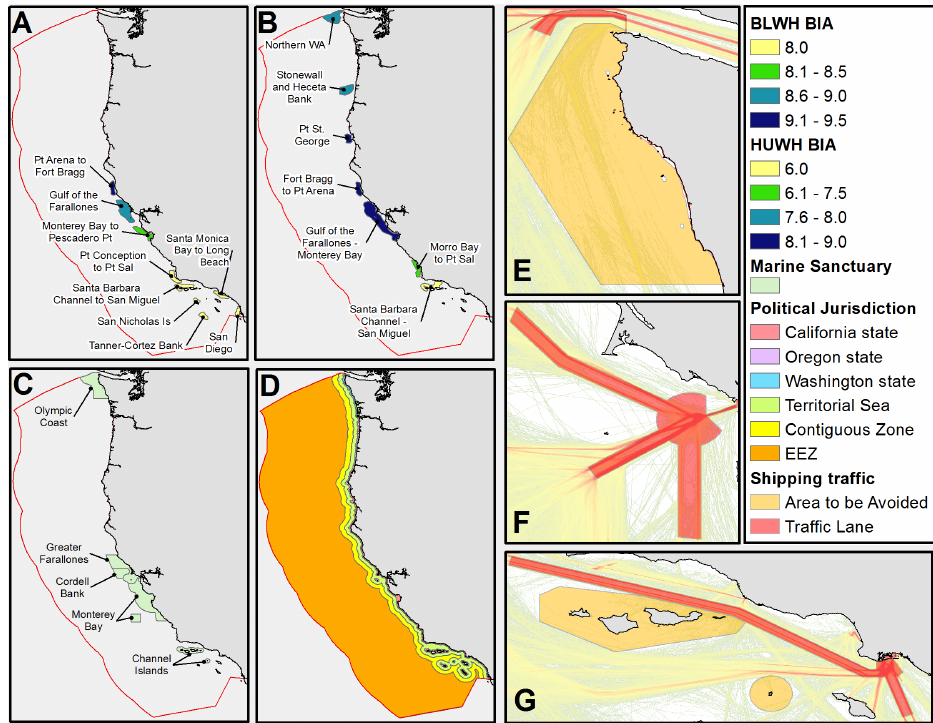
Fig 2. Jurisdictions used to assessthe distribution of mortality. BiologicallyImportant Areas (BIAs) for blue (A) and humpback(B) whalesare from Calambokidis 2015. BIA color represents the mean of the months when whalepresence occurs. Note that the scales are different for the two species. NationalMarine Sanctuaries (C) and politicaljurisdictions(D) includingstate waters (to 3 Nm; 5.6 km), territorialseas (to 12 Nm; 22.2 km), the Contiguous Zone (to 24 Nm; 44.5 km) and the Exclusive Economic Zone (to 200 nm; 555.6 km) are important for regulationson ship traffic and management of whales.Ship traffic schemes for northern Washington (E), the San Francisco Bay Area (F) and the Port of Long Beach and Santa BarbaraChannel(G) are overlaidon 2013 ship density from